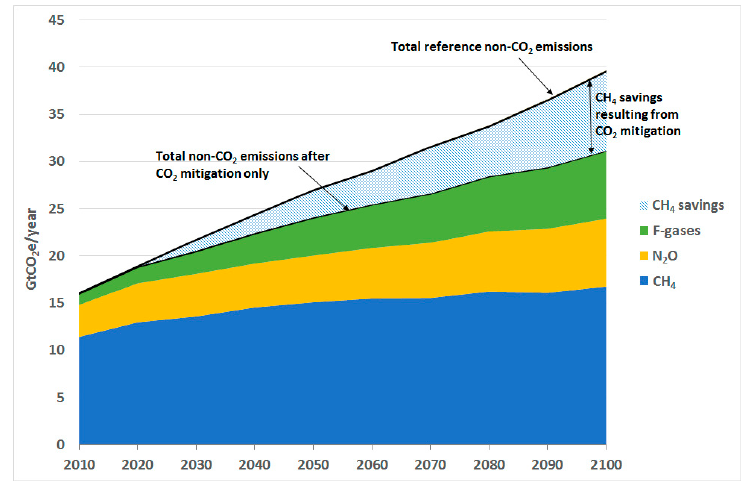
Figure 2. Non-CO 2 GHG emissions in unmitigated reference scenario, with indirect savings